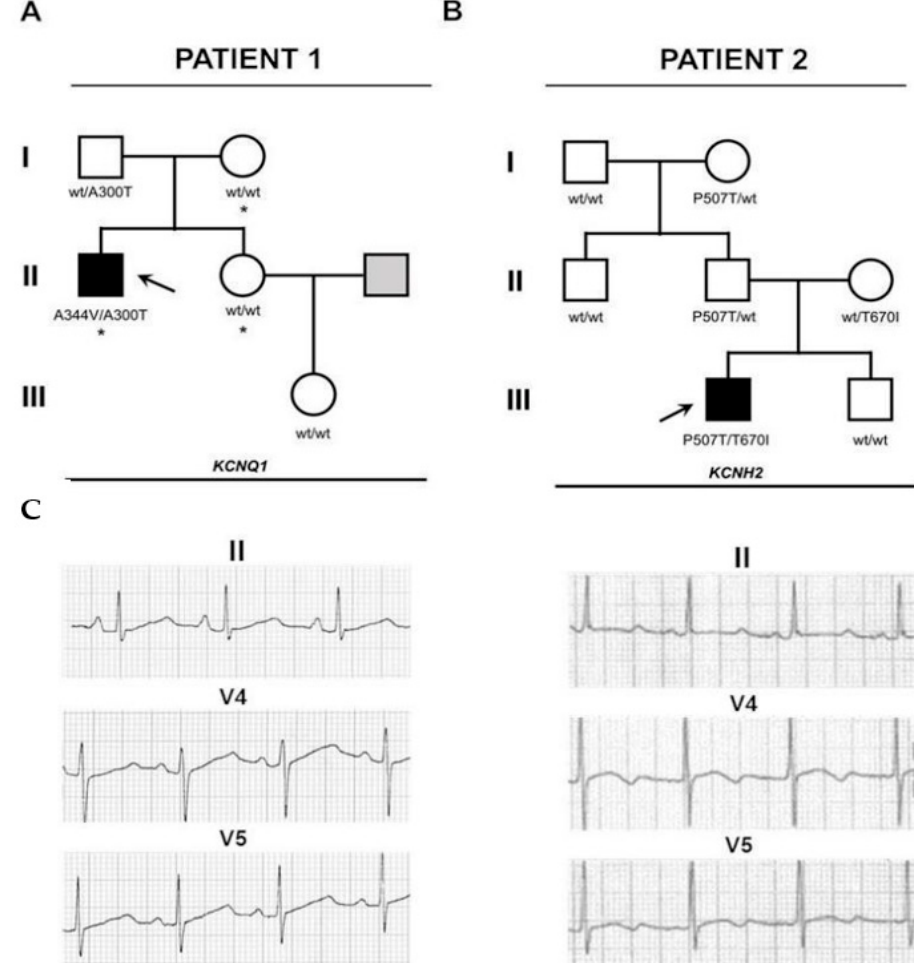
Figure 1. Family history and electrophysiological profile of the patients described in this study. ( A , B ) Familiograms showing the single affected patient in each family (arrow). Genotypes of tested individuals are shown. Individuals shaded white showed normal QT intervals. The individual shaded gray was not evaluated. The asterisk denotes patients with the SCN5A p.Ala467Ser, c.1399G > T variant. ( C ) Selected ECG derivations of the patients showing prolonged QTc interval, in the right panel, the QTc is 573 ms and the T wave is biphasic. In the left panel, the QTc is 524 ms and the T wave is bifid.